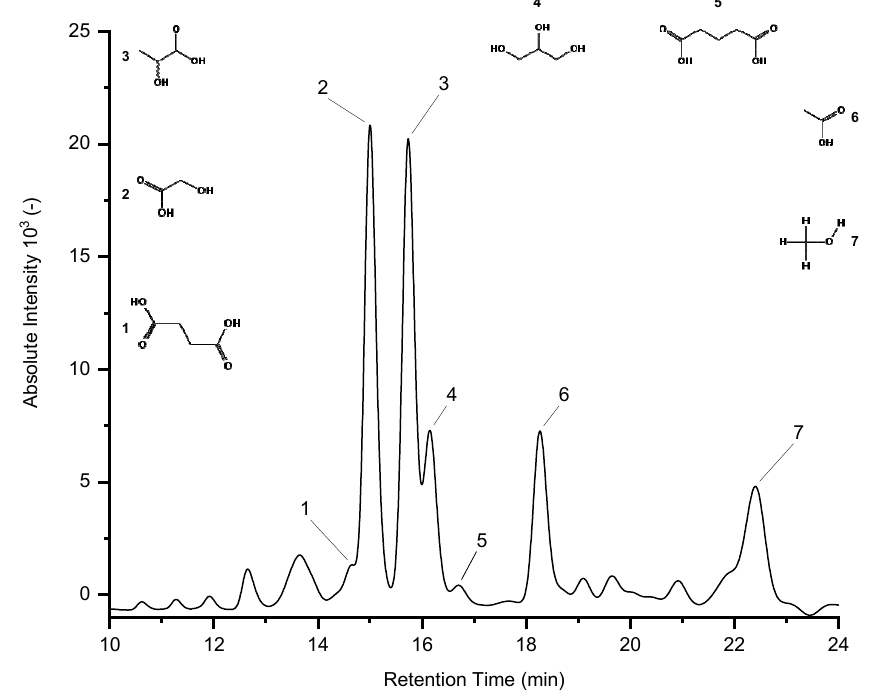
Figure 3. Typical partial HPLC chromatogram for water-soluble organics (WSO) in aqueous phase (AP) fraction obtained at 350 °C, 10 min, 10% biomass to water ratio. 1. Succinic acid, 2. Glycolic acid,